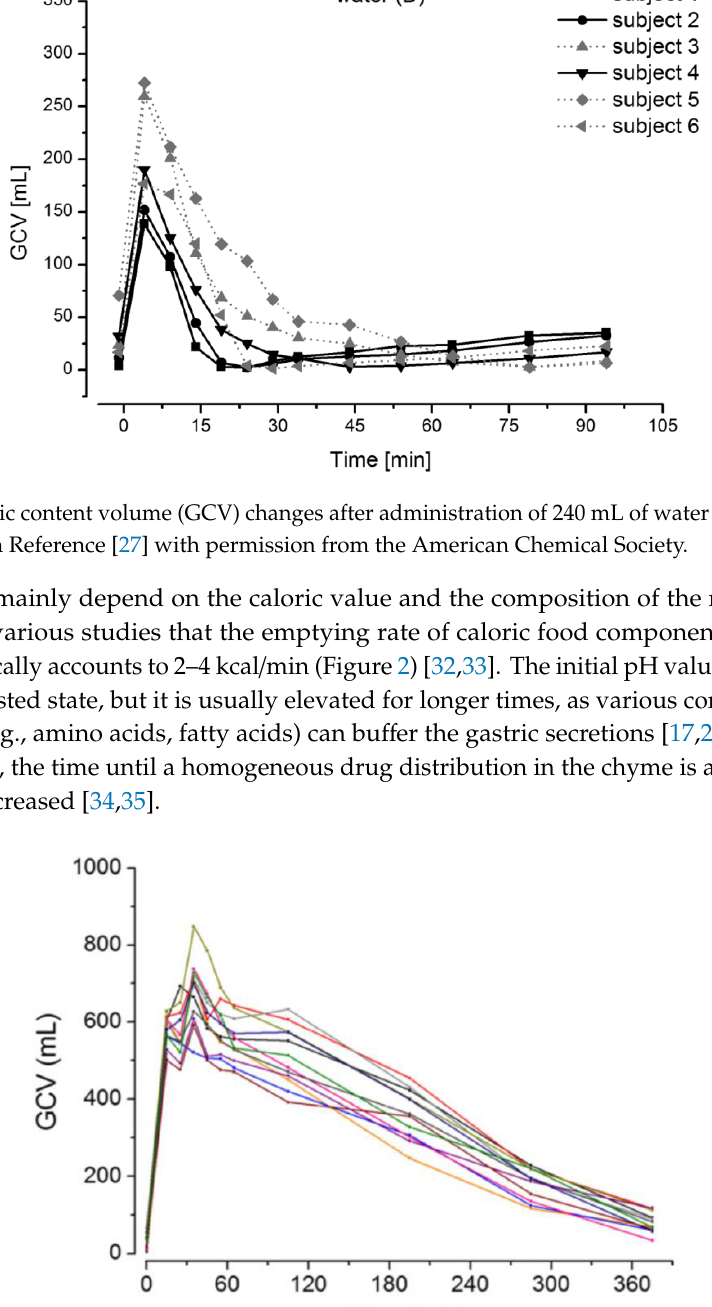
Figure 2. Gastric content volume (GCV) after intake of the high-caloric, high-fat standard breakfast as used for food-effect and fed bioequivalence studies. Reprinted from Reference [32] with permission from the American Chemical Society.